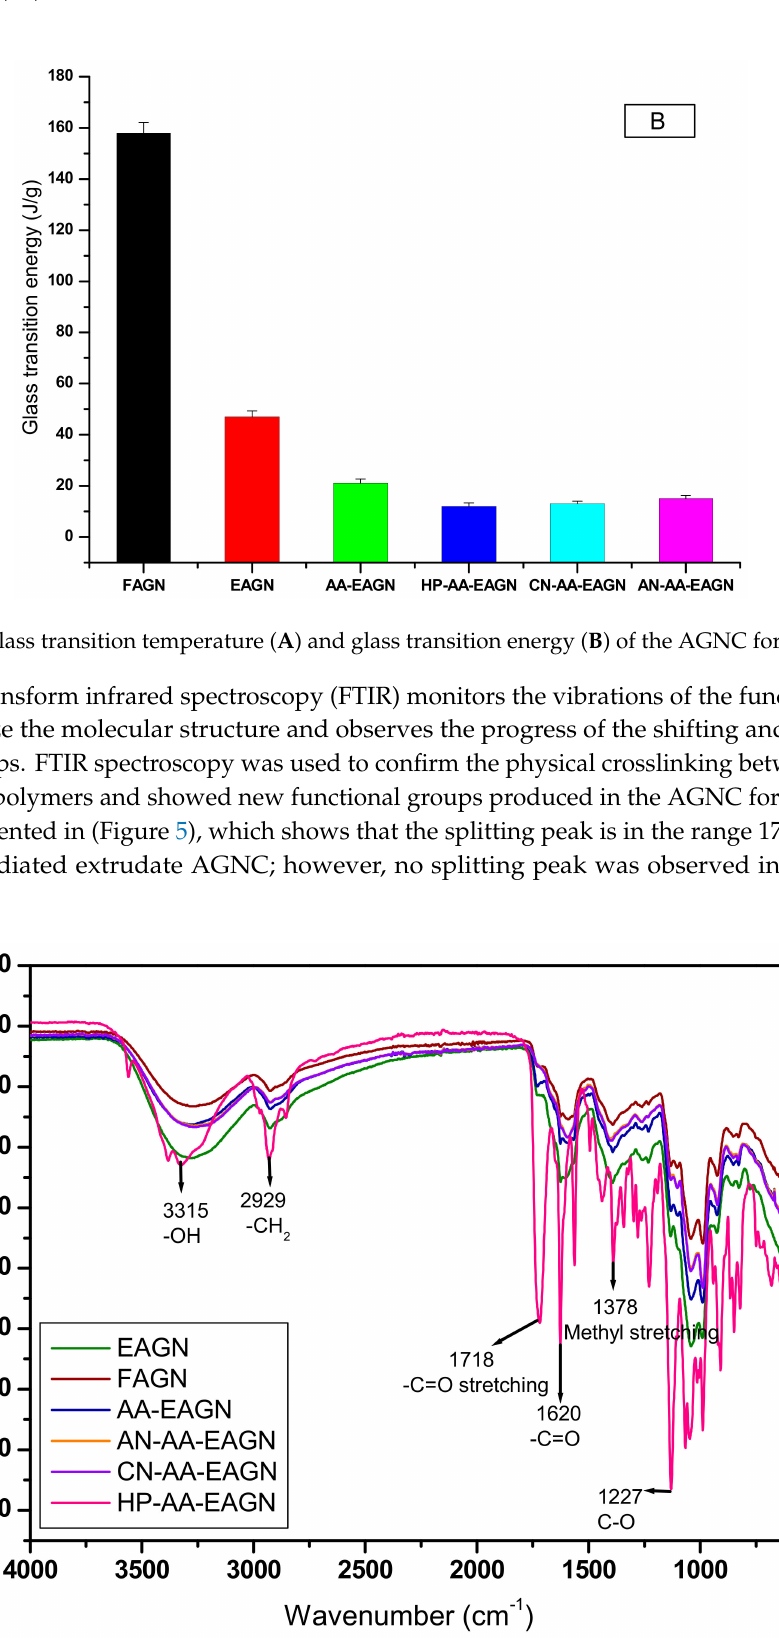
Figure 5. Fourier-transform infrared spectroscopy (FTIR) spectra of AGNC